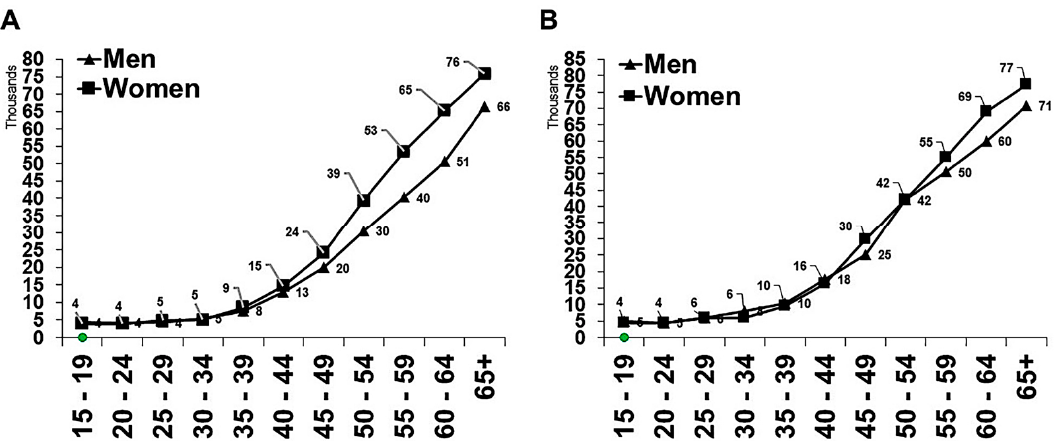
Figure 2. Age-adjusted rates of any chronic disease in ( A ) total population and ( B ) Saudi population by gender. Note. Rates are presented per 100,000 population-year.